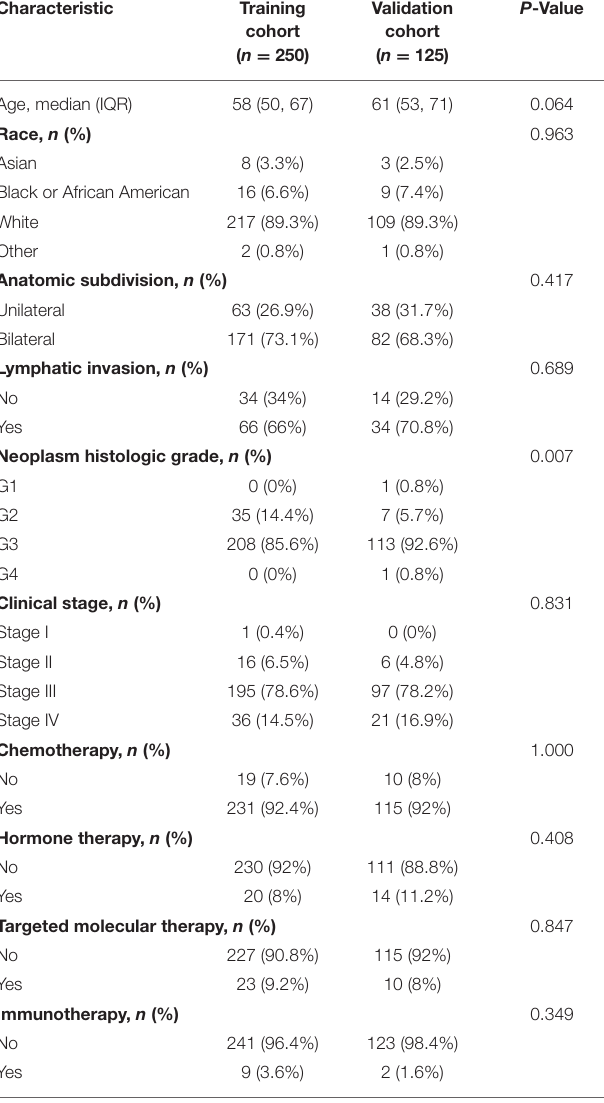
TABLE 1 | Characteristics of ovarian cancer patients in the training and validation cohorts. Characteristic